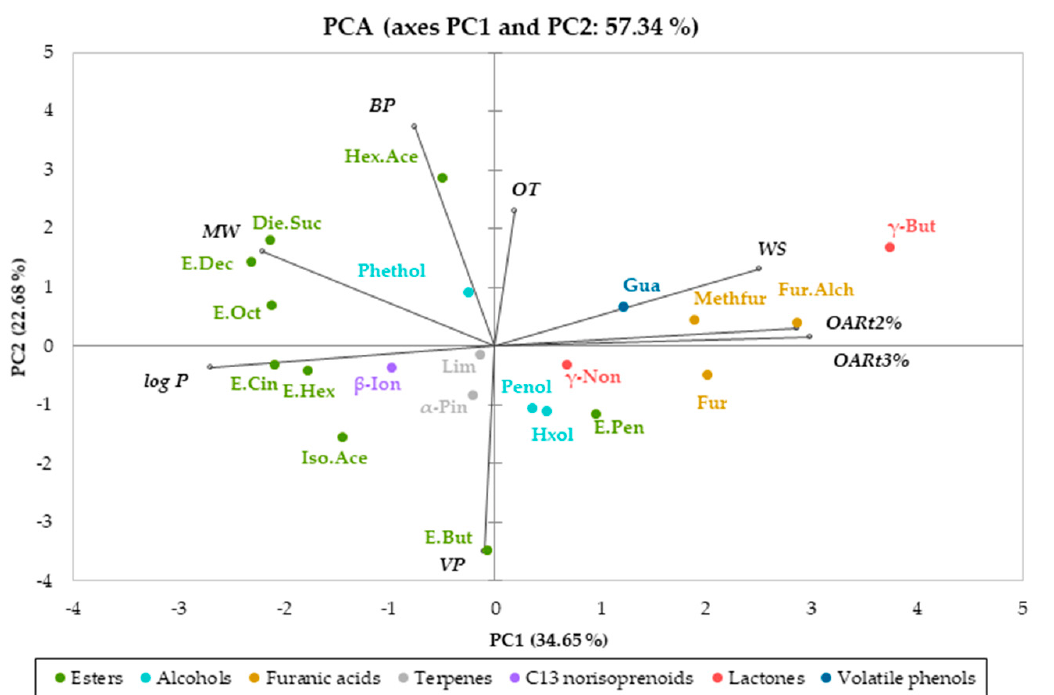
Figure 3. Principal component analysis (PCA) performed with some physicochemical features of the aroma compounds (boiling point (BP), hydrophobic constant (logP), odor threshold (OT)) and %OARt2 and %OARt3. logP: hydrophobic constant; BP: boiling point; OT: odor threshold; α -Pin: α -pinene; β -ion: β -ionone; γ -But: γ -butyrolactone; γ -Non: γ - nonalactone; Die.Suc: diethyl succinate; E.But: ethyl butanoate; E.Cin: ethyl cinnamate; E. Dec: ethyl decanoate; E.Hex: ethyl hexanoate; E. Oct: ethyl octanoate; E.Pen: ethyl pentanoate; Fur: furfural; Fur.Alc: furfuryl alcohol; Gua: guaiacol; Hex.Ace: hexyl acetate; Hxol: hexanol; Iso.Ace: isoamyl acetate; Lim: limonene; Methfur: 5-methyl furfural; Phethol: phenylethanol; Pntol: